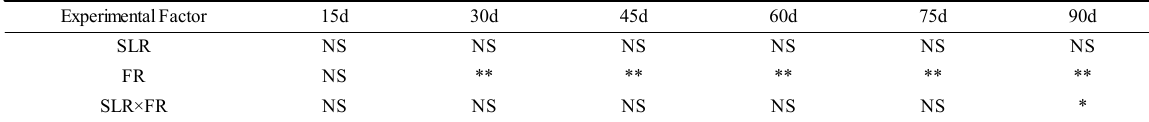
Figure 2. Effects of SLR and FR on stalk diameter. Note: Bars represent means ± standard deviation ( n = 3) with different letters indicating significant differences based on LSD ( p ≤ 0.05). SLR, sugarcane leaf return; FR, fertilizer reduction.